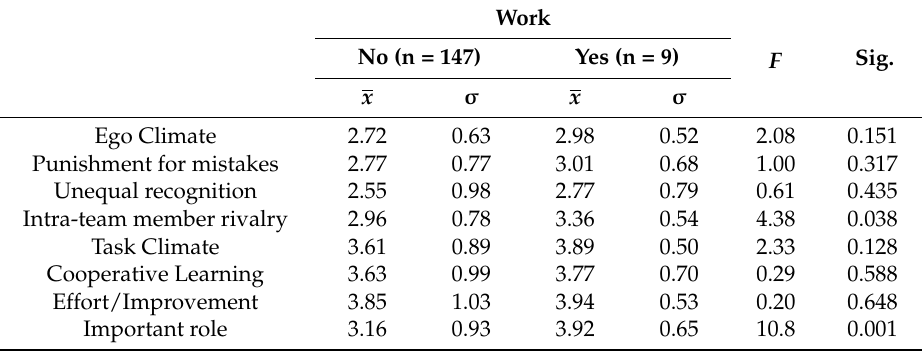
Table 4. Motivational Climate according to